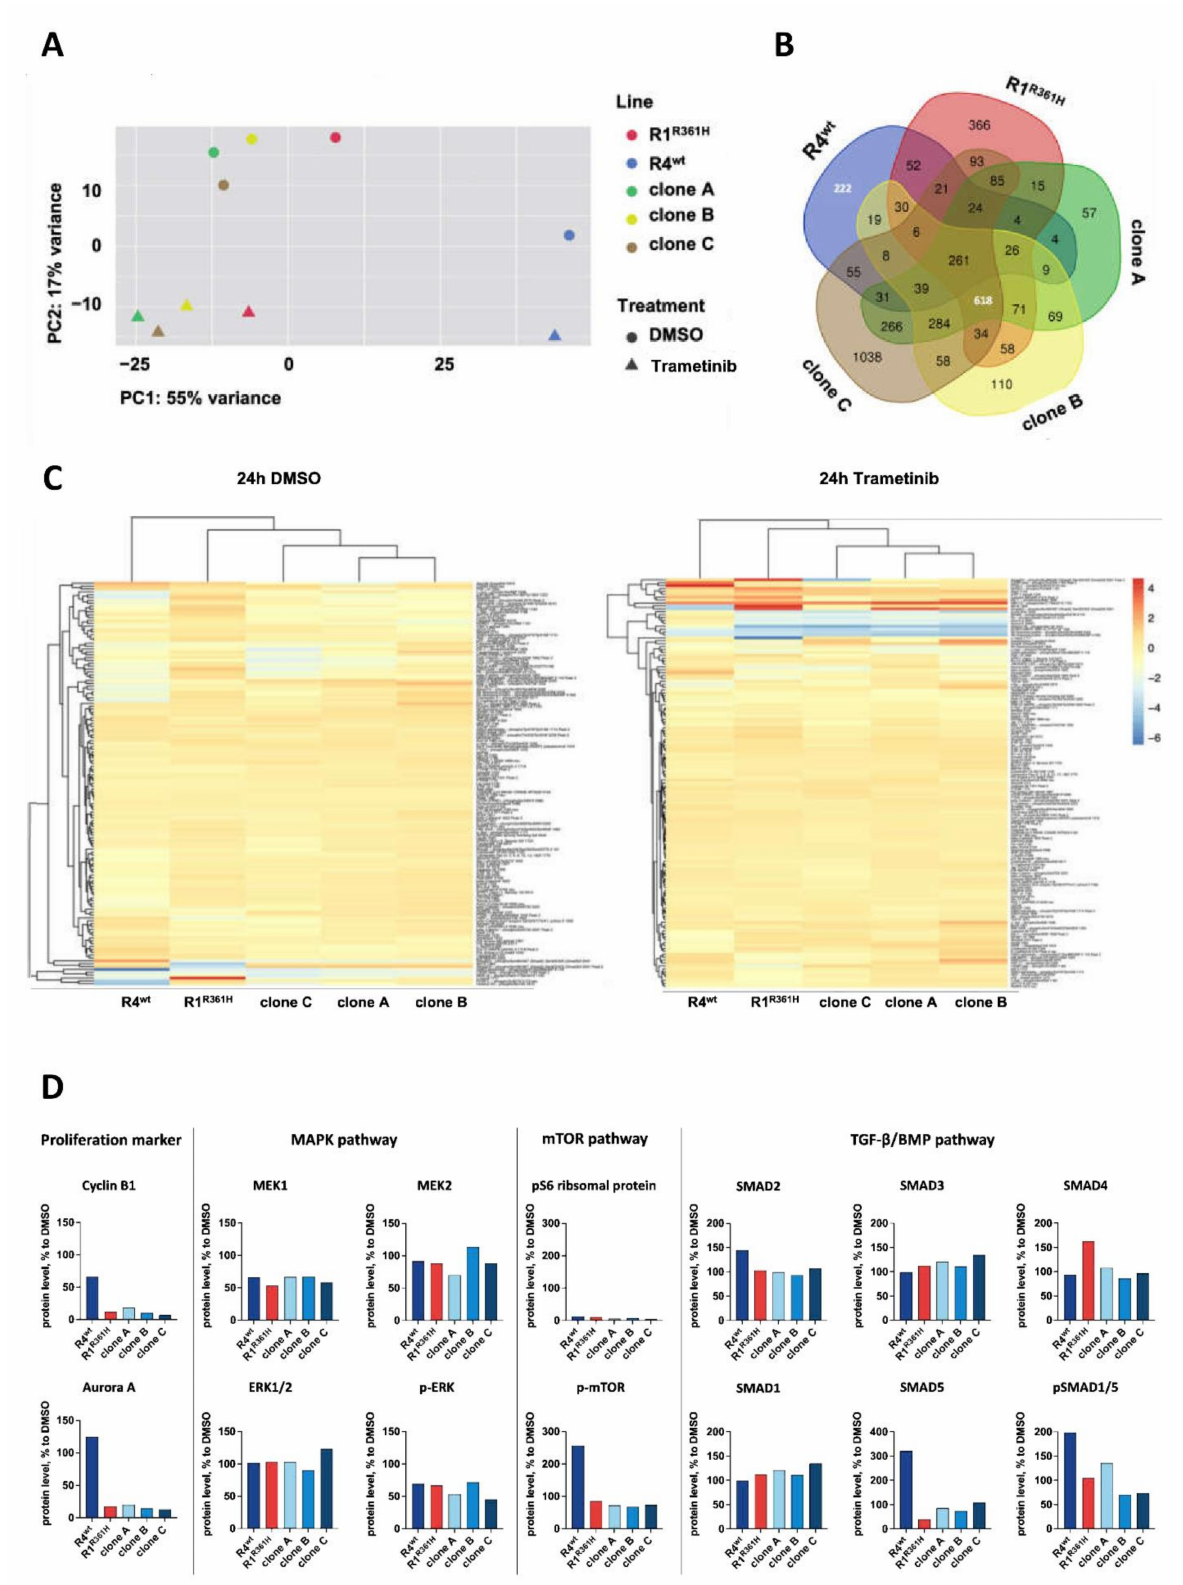
Figure 3. BMP-pathway is activated in SMAD4 wt cells in response to MEK-inhibition. ( A ) Princi- pal Component Analysis of mRNA expression of R4 wt , R1 R361H , and CRISPR- SMAD4 R361H PDOs (clones A, B, and C). The first component on the x -axis contains 55% of the variance and classifies